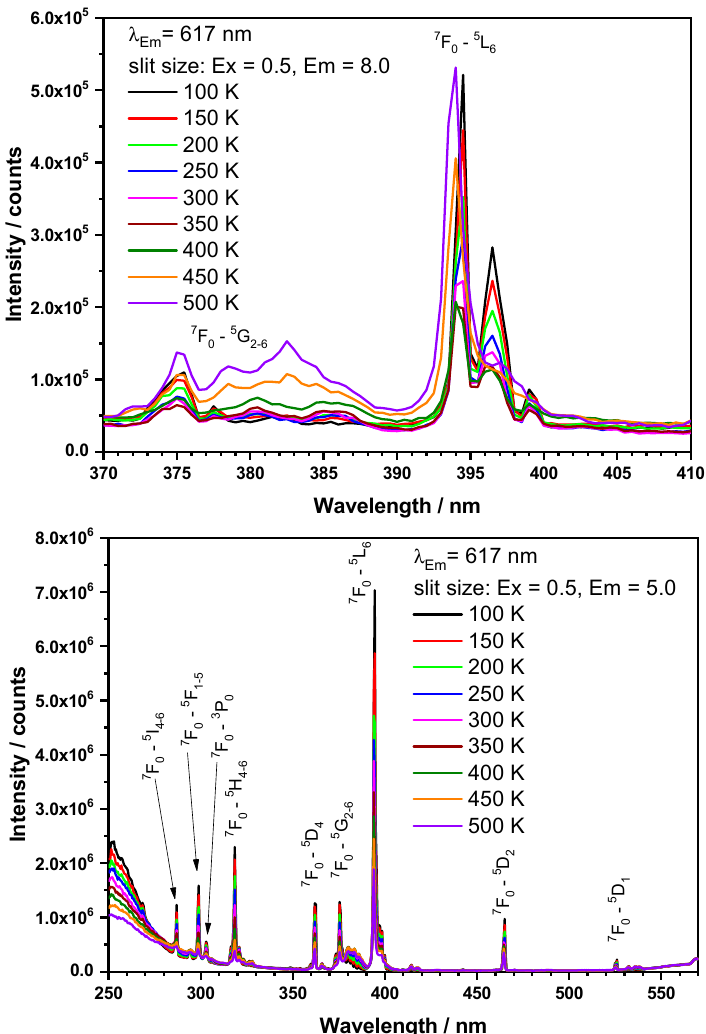
Figure 13. Excitation spectra of NaY[SO 4 ] 2 ∙ H 2 O:Eu 3+ ( top ) and NaY[SO 4 ] 2 :Eu 3+ ( bottom ) as a function of temperature between 100 and 500 K.